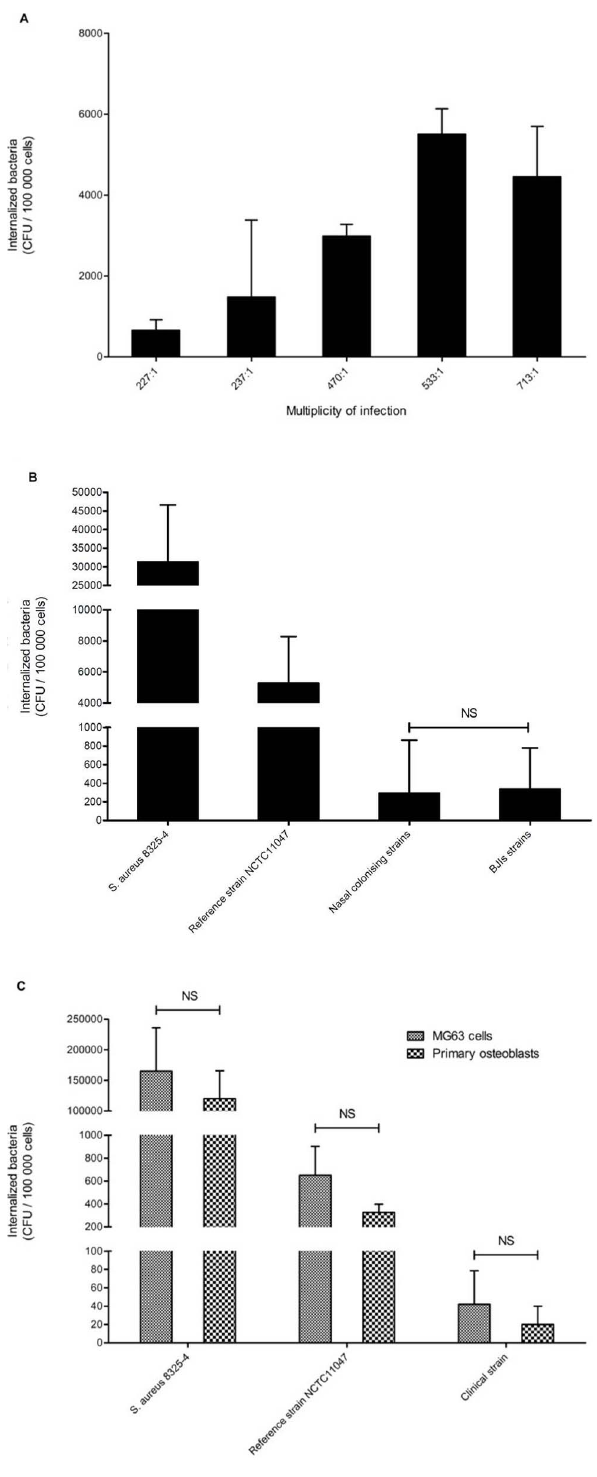
Figure 2. Invasion of human osteoblasts by S. epidermidis clinical isolates. A. Determination of the optimal multiplicity of infection (MOI) for use in osteoblast invasion assays (reference strain NCTC11047). B. Evaluation of the rate at which S. epidermidis strains invade the MG63 osteoblastic cell line for nasal colonization (n=22) versus orthopedic infection (n=15) isolates. C. Comparison of the invasion rate in MG63 osteoblastic cells and primary human osteoblasts for S. aureus 8325-4, S. epidermidis NCTC11047, and one randomly chosen S. epidermidis clinical isolate. Data are represented as the